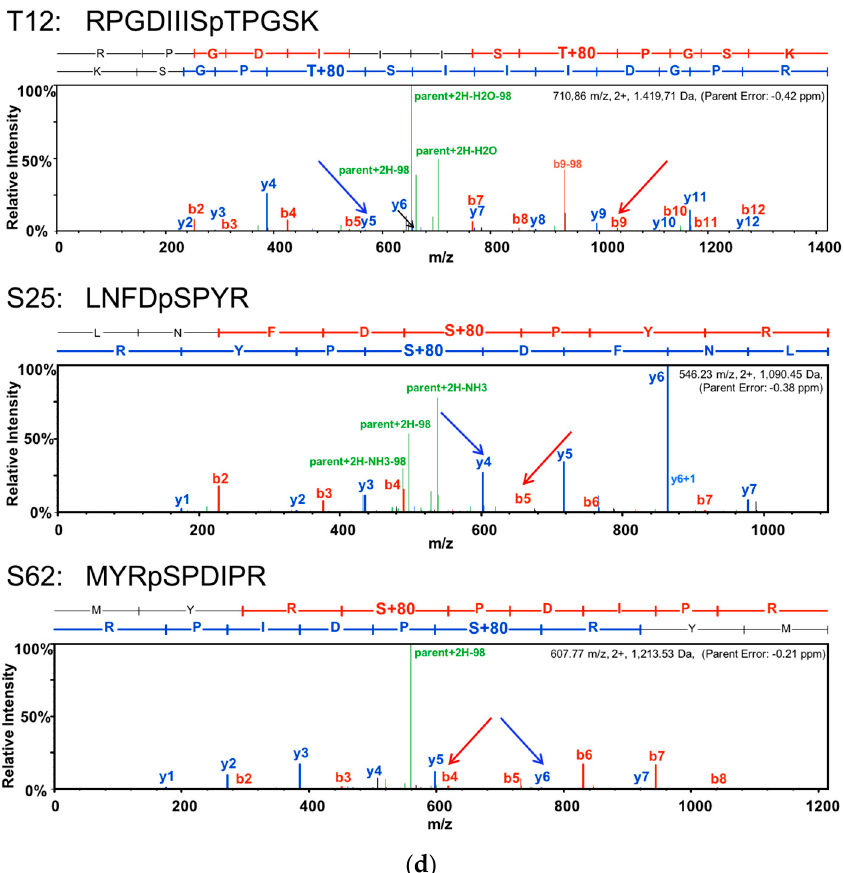
Figure 1. African cassava mosaic virus (ACMV) capsid protein (CP) expression in fission yeast. Cells with pESP1 ‐ pREP2:AV1 (CP) or pESP1 ‐ pREP2 (V) were harvested at 9, 12, 15 and 18 h post induction (hpi) without thiamine for induction (+) or with thiamine for repression ( − ). Cell extracts separated into supernatant ( a ) and pellet ( b ) fractions by low ‐ speed centrifugation were analyzed by SDS ‐ polyacrylamide gels (SDS ‐ PAGE) applying 100 μ g protein per lane, Western blotted and CP was detected immunologically. Bands of monomeric CP (filled and open arrowheads) and dimers (asterisks) are indicated. Marker proteins (M) with molecular weights (kDa) and standard pCP (S) are compared. ( c ) mass spectrometry results. Amino acid sequence of ACMV CP with amino acids on grey background if unmodified and on black background for modification by phosphorylation. Tryptic peptides with a white background have not been identified; ( d ) mass spectrometric analysis of phosphopeptides. Fragmentation spectra of tryptic peptides containing phosphorylation sites T12, S25, and S62, respectively. Fragments matching the expected sequence are shown in red (b series) and blue (y series) with the peaks corresponding to the fragment ions ending at the phosphorylated residue highlighted by red and blue arrows, respectively.